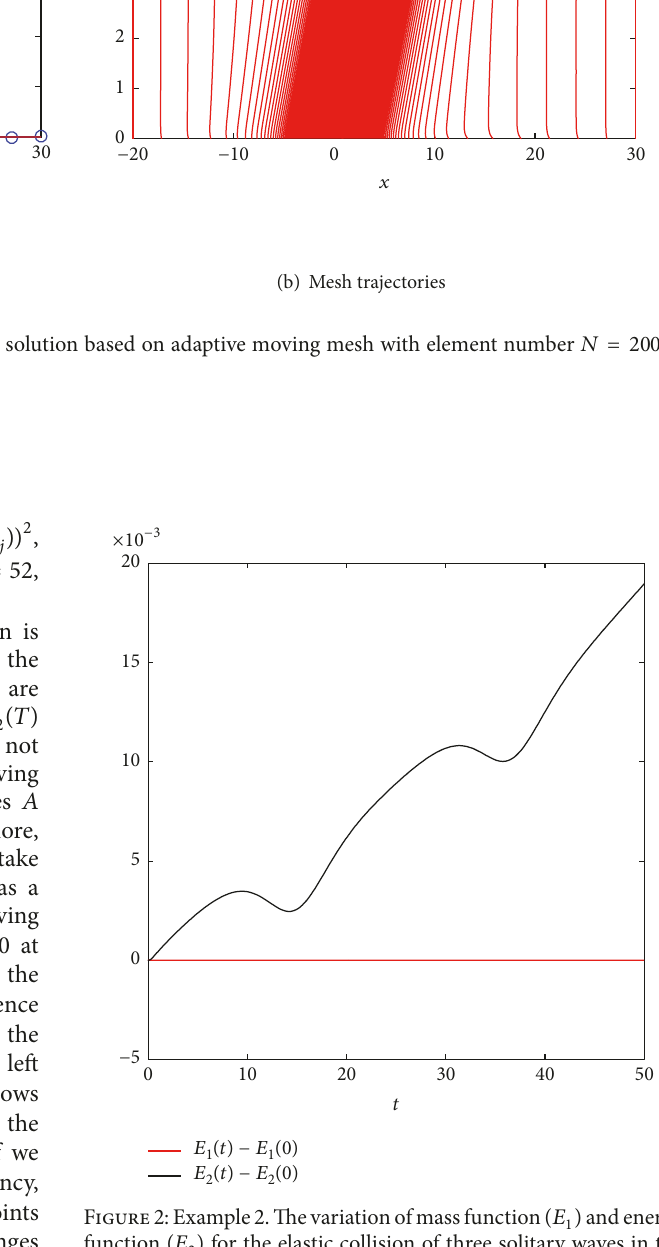
Figure2:Example2.Thevariationofmassfunction( 𝐸 1 )andenergy function ( 𝐸 2 ) for the elastic collision of three solitary waves in the BBM-Burgers